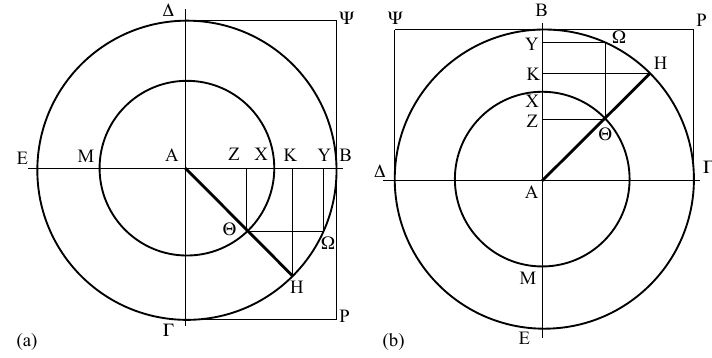
Figure 1. Vertical ( a ) and horizontal ( b ) motion according to